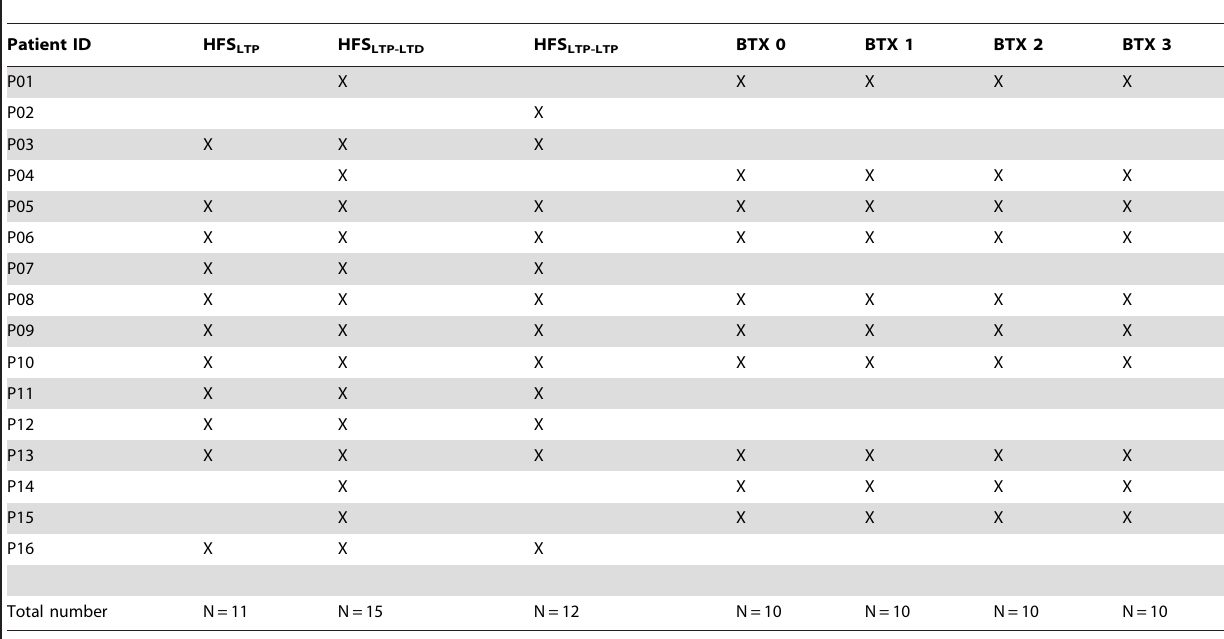
Table 2. Protocols in which each individual patient participated at the different time